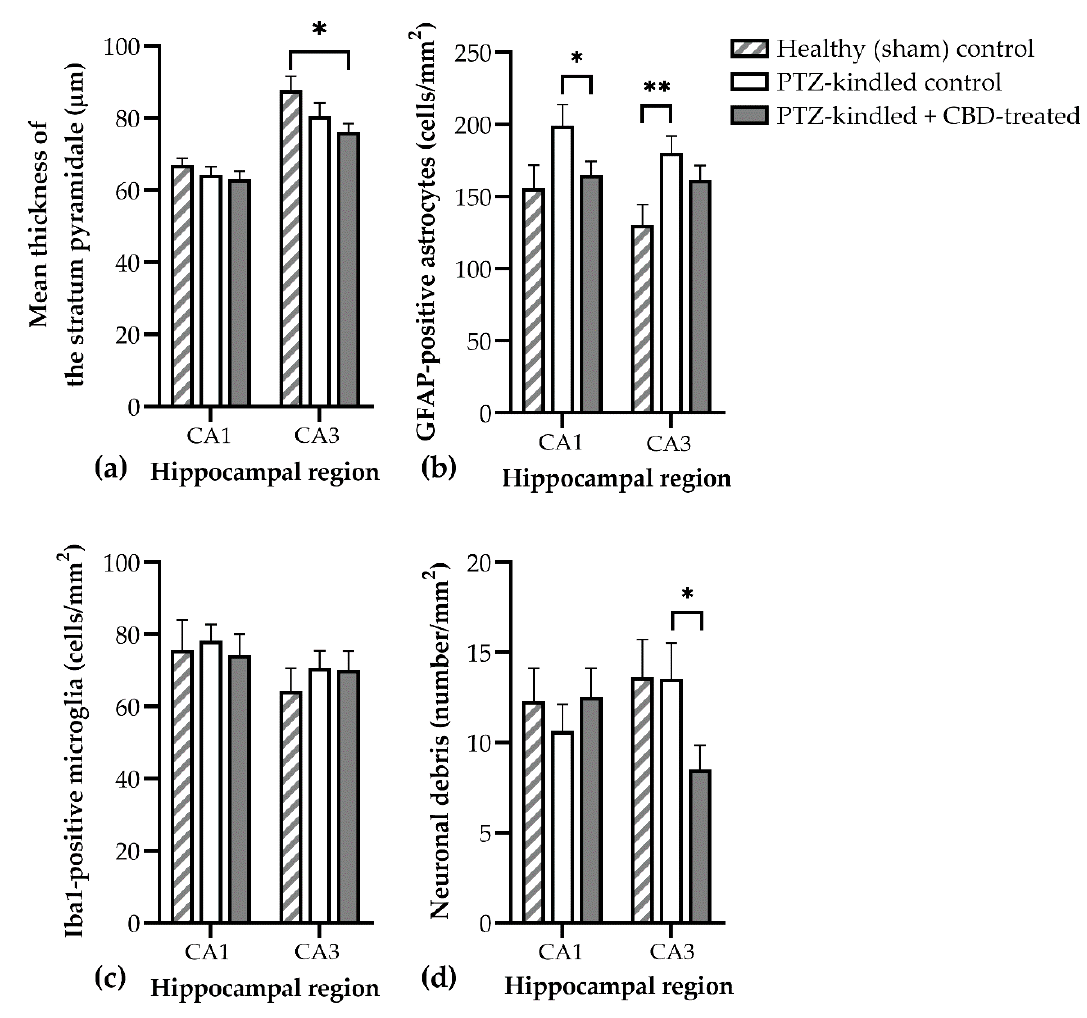
Figure 8. Effects of chronic CBD (60 mg/kg body weight) treatment on the hippocampal reorga- nization induced by PTZ-kindling in rats. ( a ) Mean thickness of the pyramidal cell layer; ( b ) the density of GFAP-positive astrocytes; ( c ) the density of IBA1-positive microglia; ( d ) the density of neuronal debris, defined as NeuN-positive fragments surrounded by astrocytes. Data are expressed as mean ± SEM ( n = 5–8).; CBD, cannabidiol; * p < 0.05; ** p < 0.01.